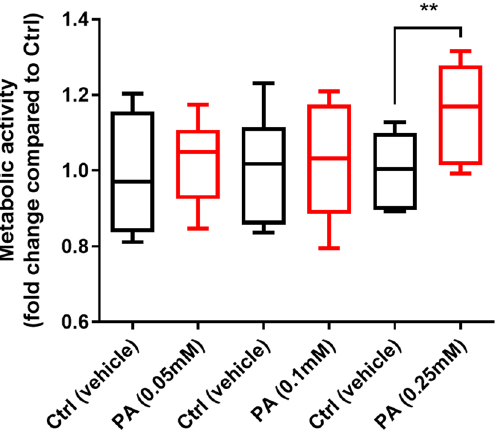
Figure 4. Palmitic acid enhances Giardia trophozoites’ metabolic activity. Levels of resorufin converted from resazurin by G. duodenalis trophozoites (isolate NF) at 37 °C for 90 min. Resorufin fluorescence was read at λexc = 550 nm; λem = 590 nm. Data are represented as fold-change compared to control. Ctrl = control (vehicle); PA = Palmitic acid. Data are shown as box plots with min/max whiskers; ** p <